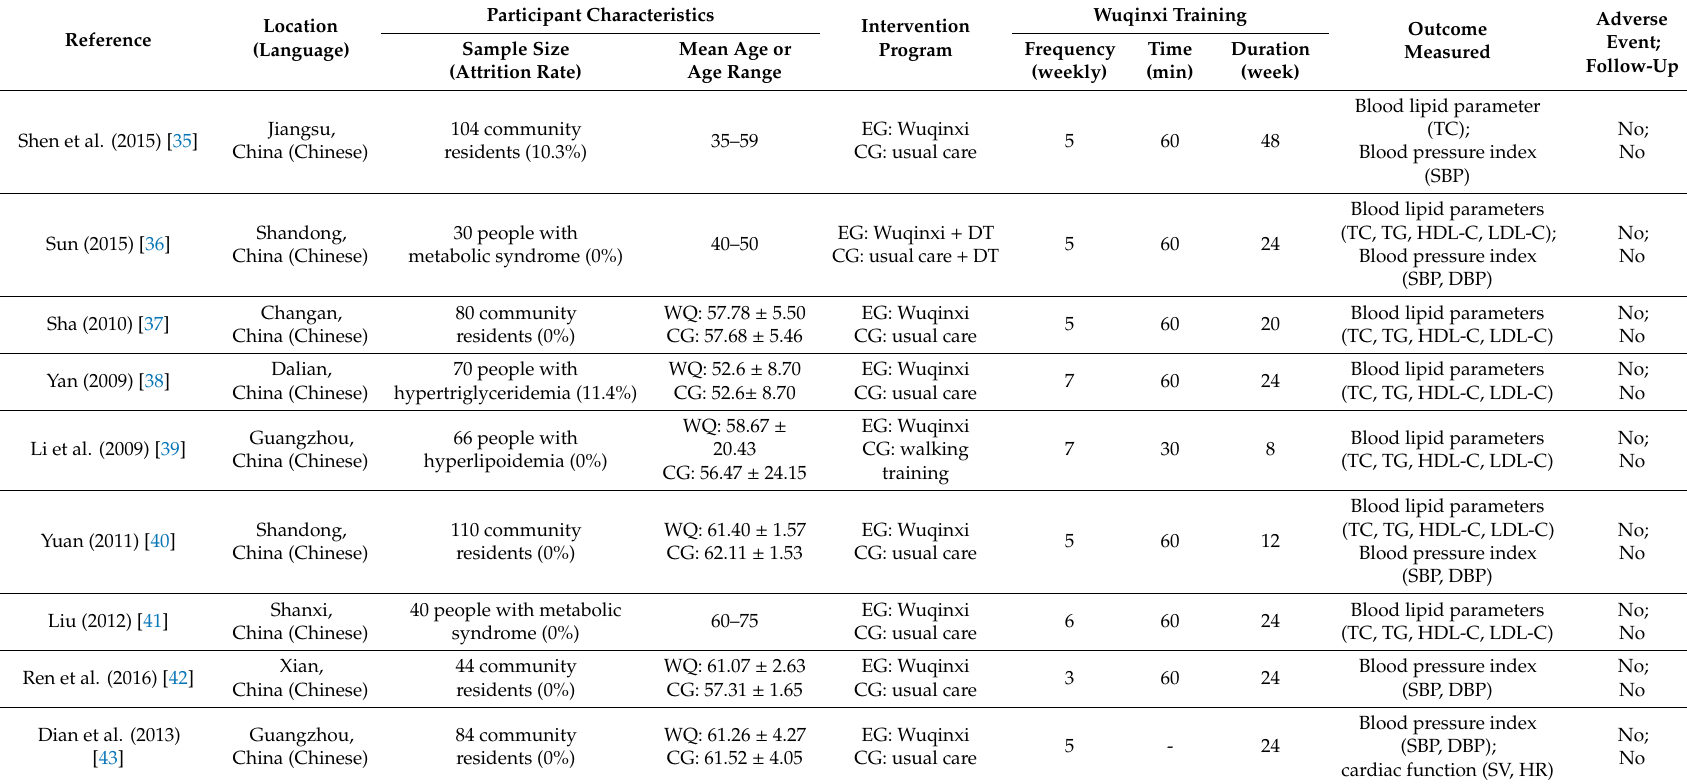
Table 1. Summary of included